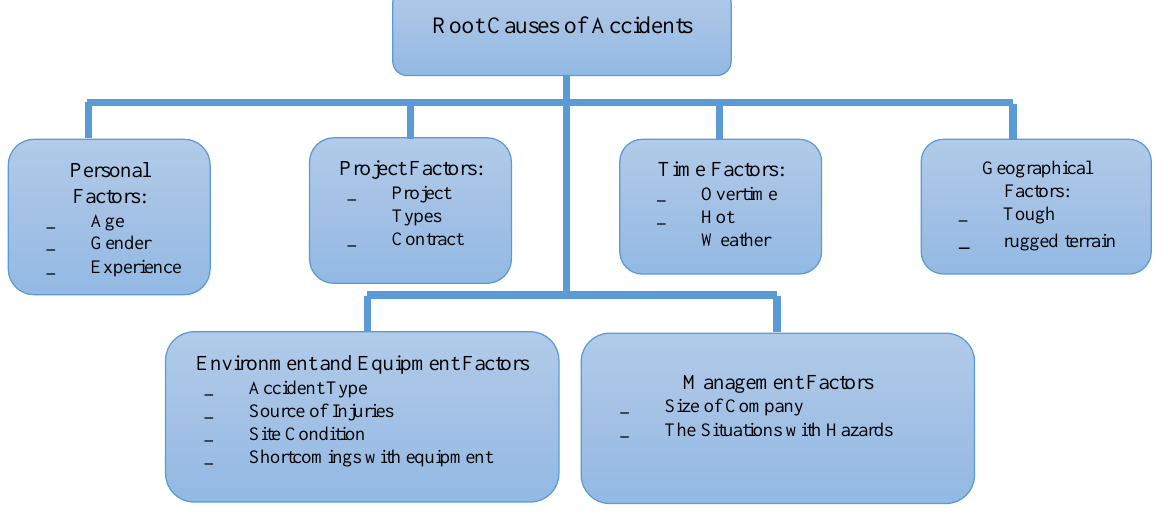
Figure 2. The root causes of accidents in Mega construction projects. “Source: Authors”